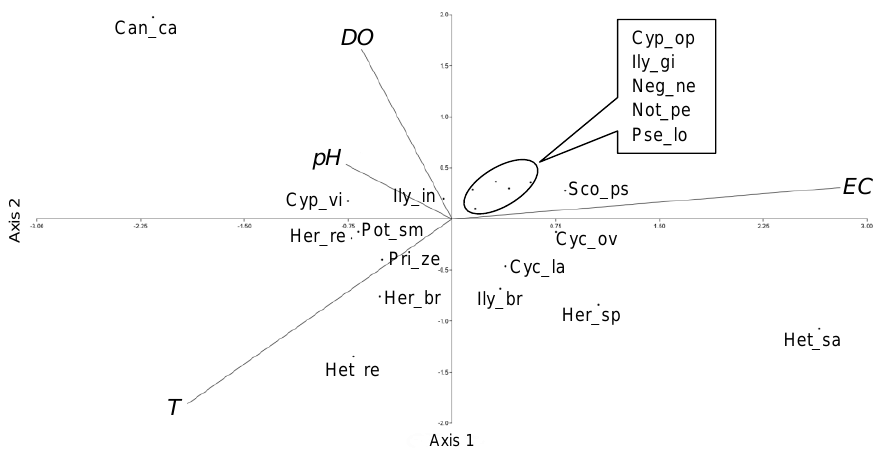
Figure 6. Canonical correspondence ordination of ostracods and environmental variables on the space defined by the first two canonical axes. The only significant variables ( p < 0.05) in explaining species